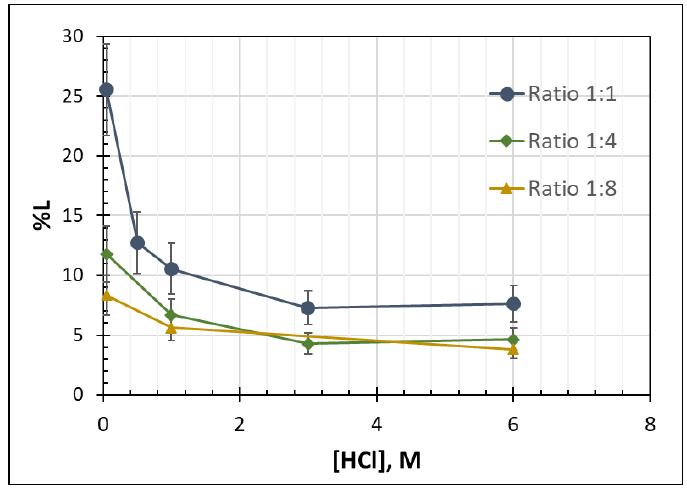
Figure 4. Losses % (%L) of ionic liquid [Hbet][Tf 2 N] in the final aqueous stripping solution.